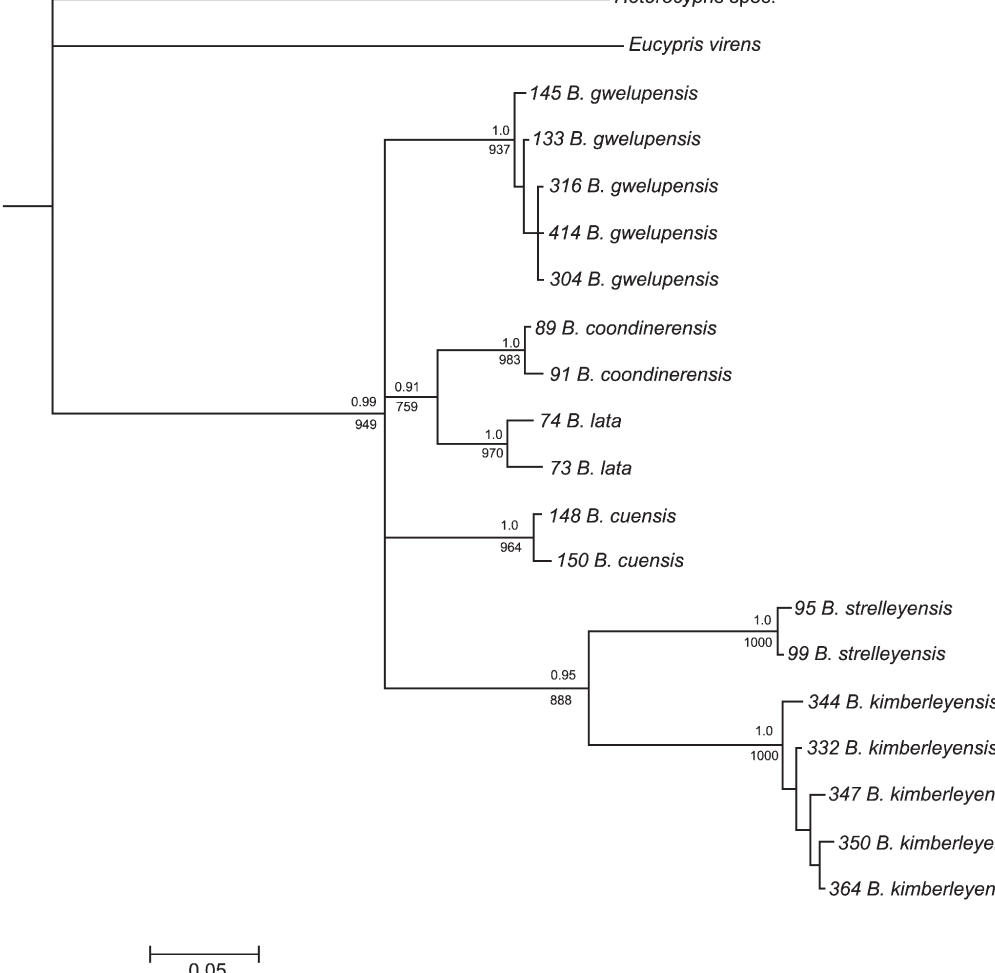
Fig. 2. Phylogenetic tree constructed with Baysian Inference of 53 COI sequences of Bennelongia and with Heterocypris spec. and Eucypris virens as outgroups. Numbers above and below nodes